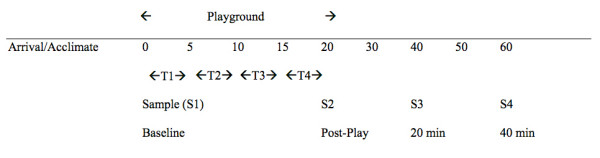
Time line for cortisol sampling before and following peer interaction. Figure T1 = Gross Motor Play, T2 = Solicited Motor Play, T3 = Cooperative Play, T4 = Solicited Cooperative Play. S1 = Baseline (Preplay), S2 = Postplay, S3 = 20 minutes Postplay, S4 = 40 minutes Postplay.